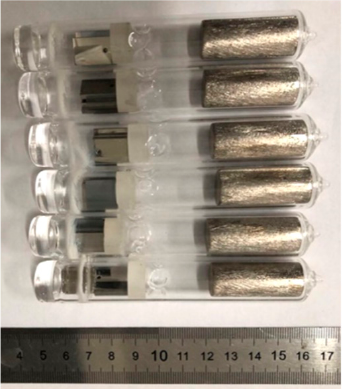
Figure 2. Quartz tube and T91 samples.